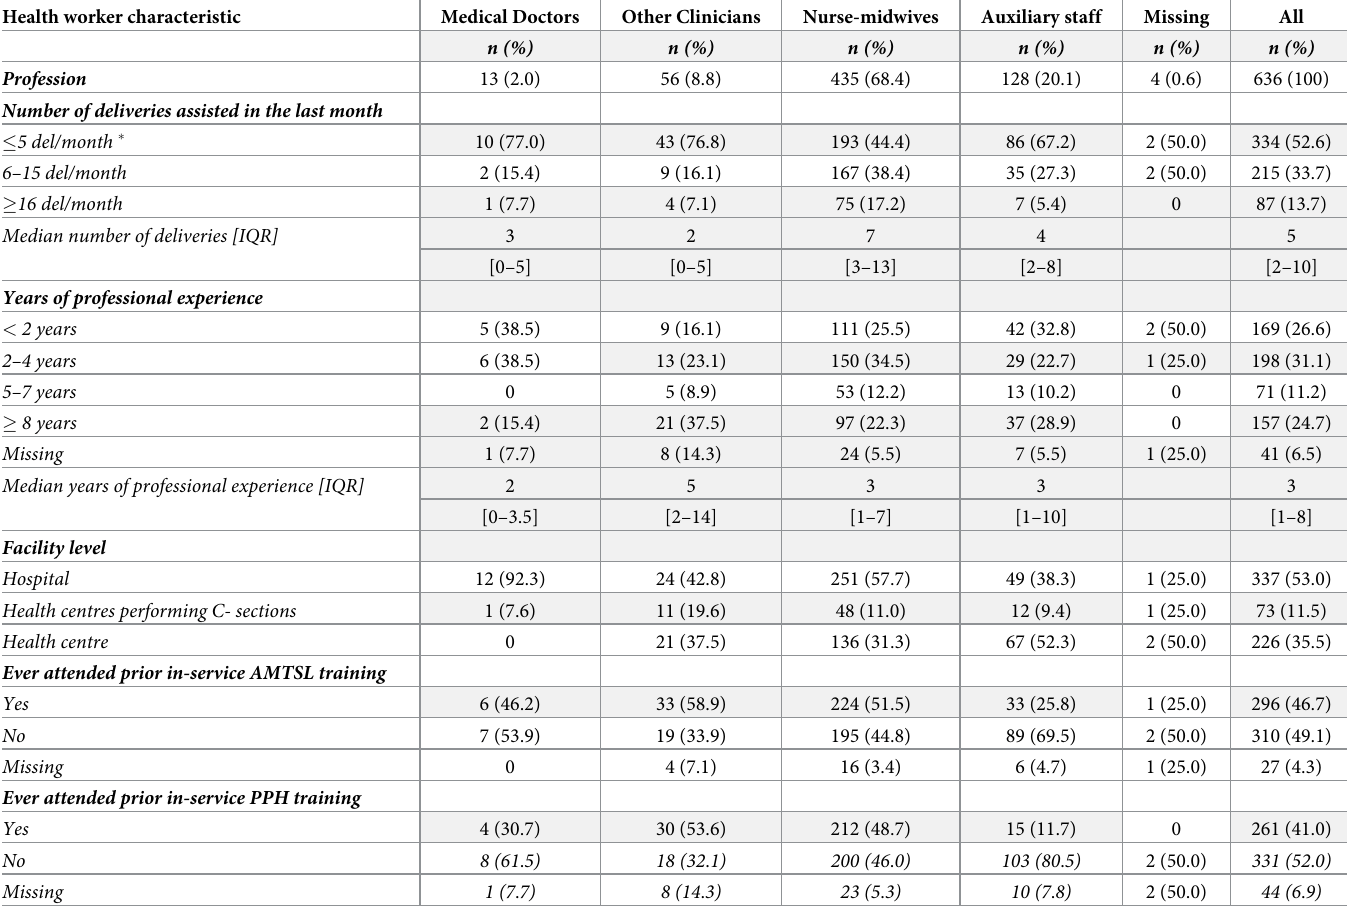
Table 1. HMS BAB trained health workers by professional characteristics (n =